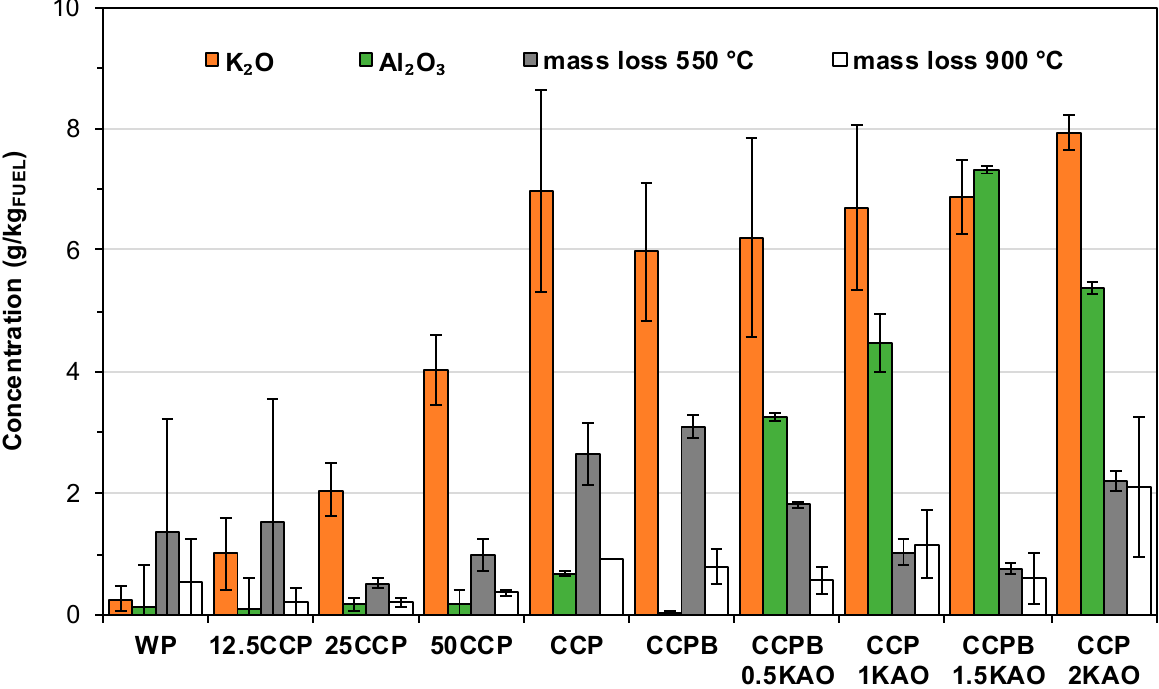
Figure 6. Concentration of selected species in grate ash (for experimental list see Table 2). Table 4. Crystalline phases identified in the grate ash (GA) samples (for experimental list see Table 2). Crystalline Phase